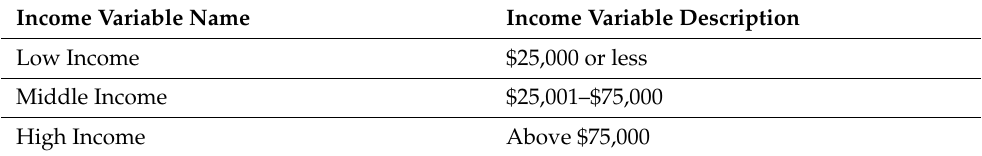
Table 1. Income Variable Categories.